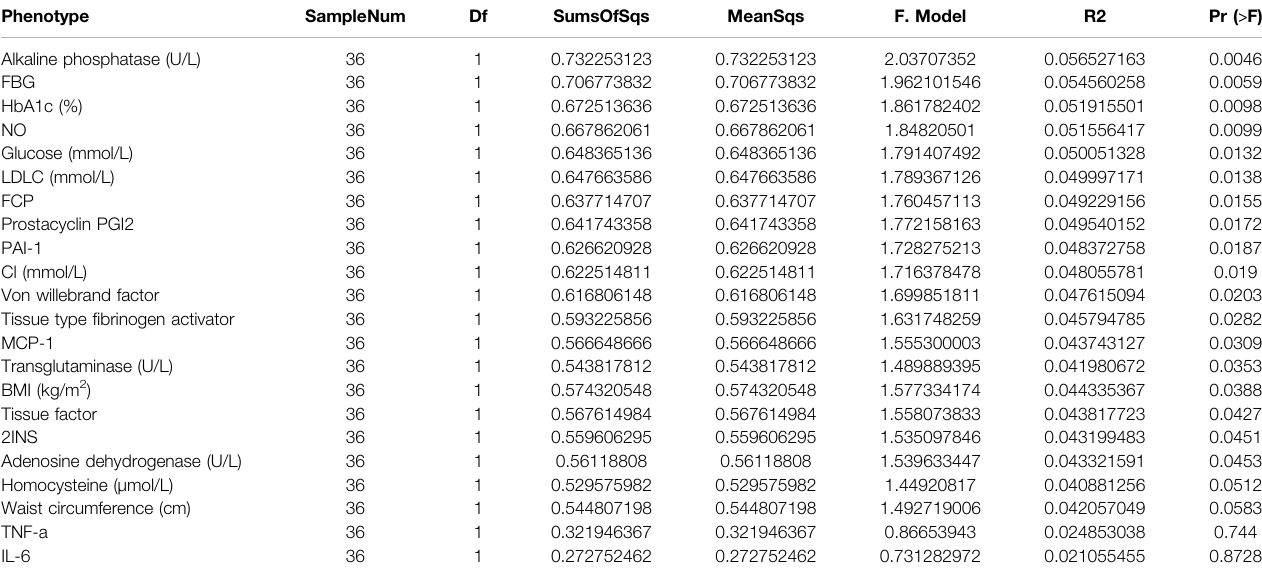
TABLE 3 | Clinical indicators associated with intestinal